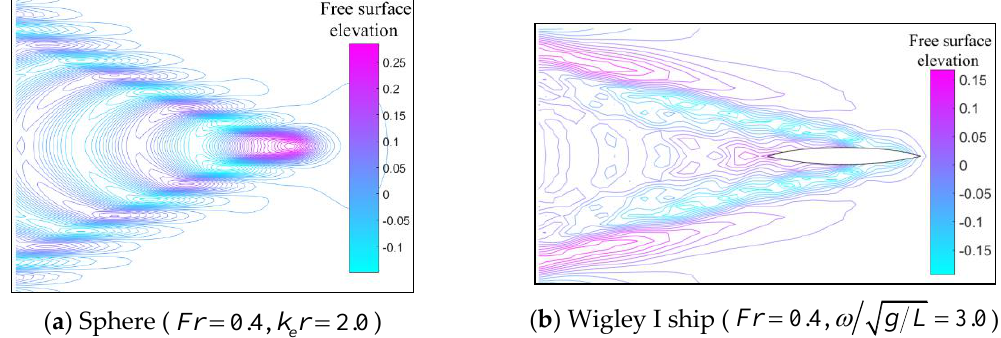
Figure 9. Real part of the heave radiation wave contour of ( a ) submerged sphere and ( b ) Wigley I